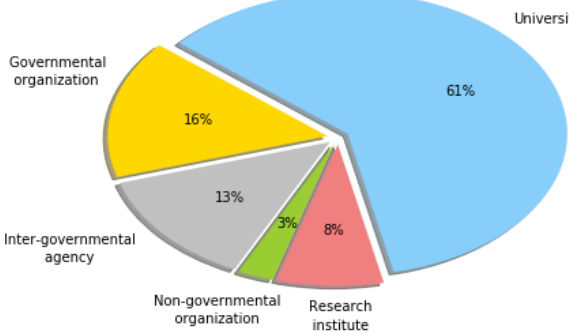
Figure 3. Affiliation types of the respondents to the first survey Respondents highlighted the use of LC maps for a huge